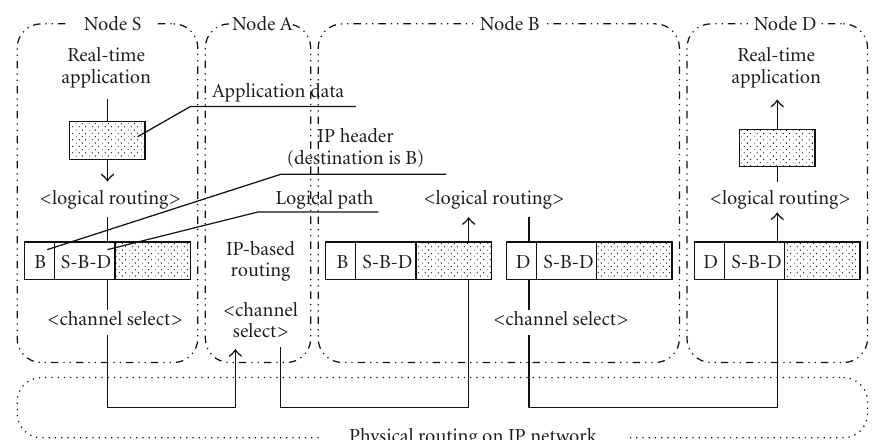
Figure 2: Packet processing in proposed